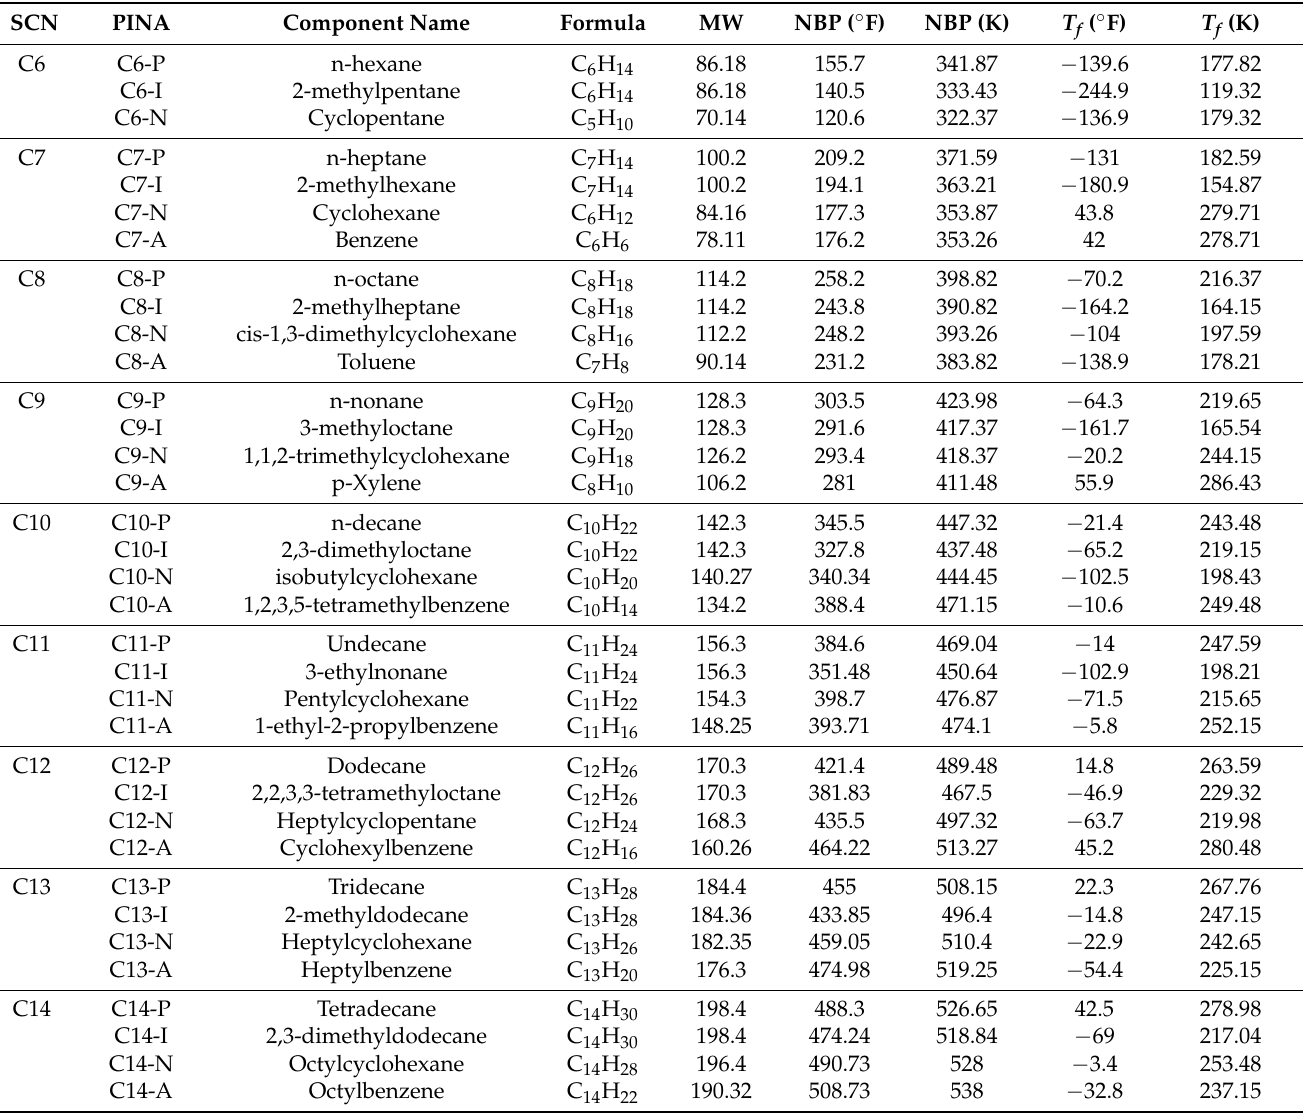
Table 13. Discrete compounds used by the PINA Attalla method to represent the paraffin, isoparafin, naphthenic aromatic (PINA) classes of single carbon number (SCN) pseudocomponents to C 14 , together with their normal boiling point (NBP), molecular weight (MW) and melting temperature T f